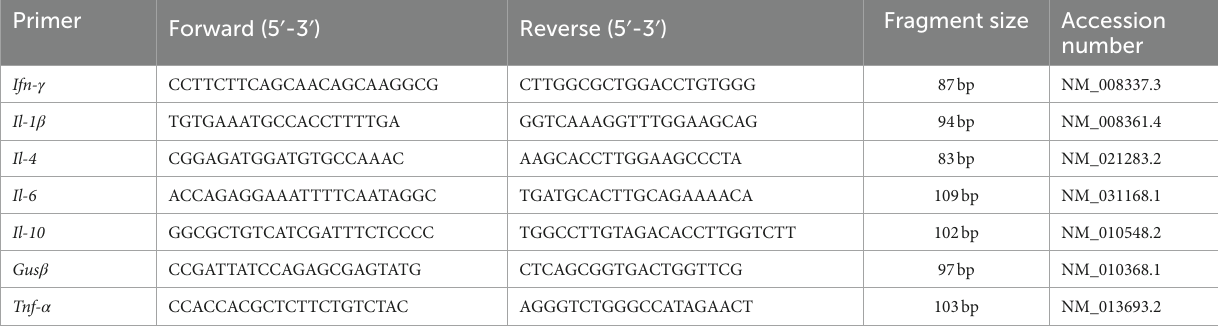
TABLE 2 Primers used for analysis of cytokine